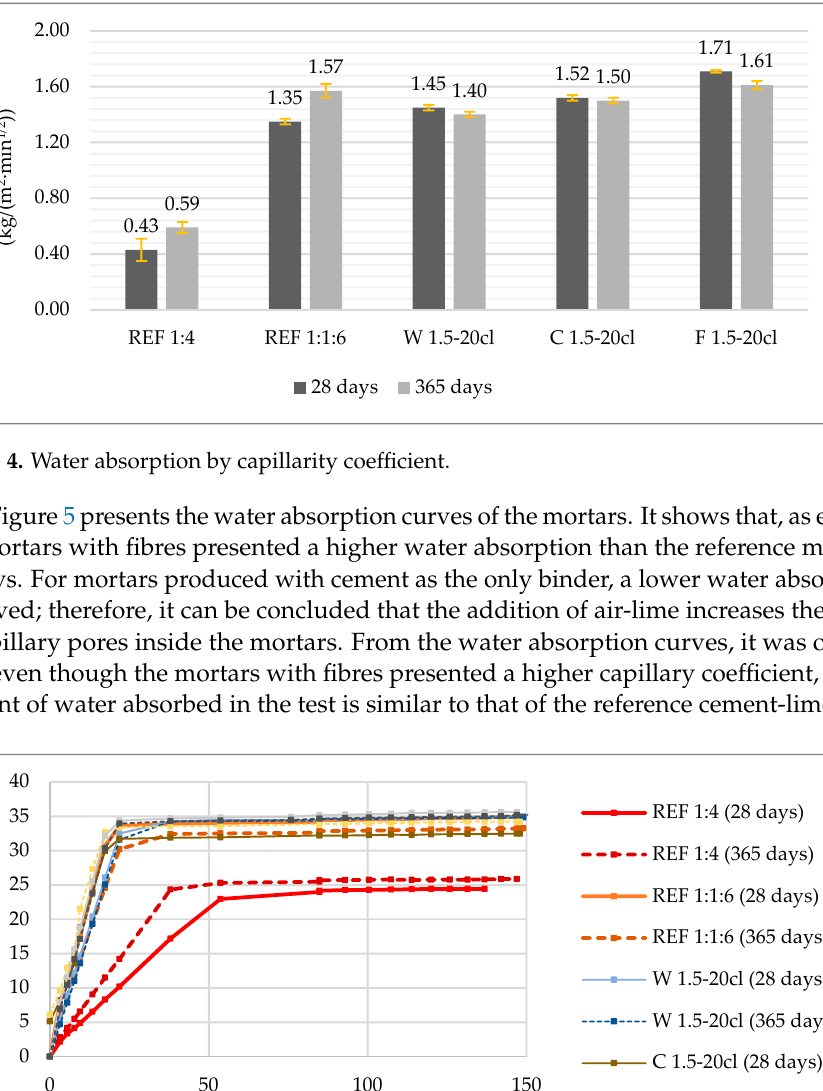
Figure 4. Water absorption by capillarity coefficient.